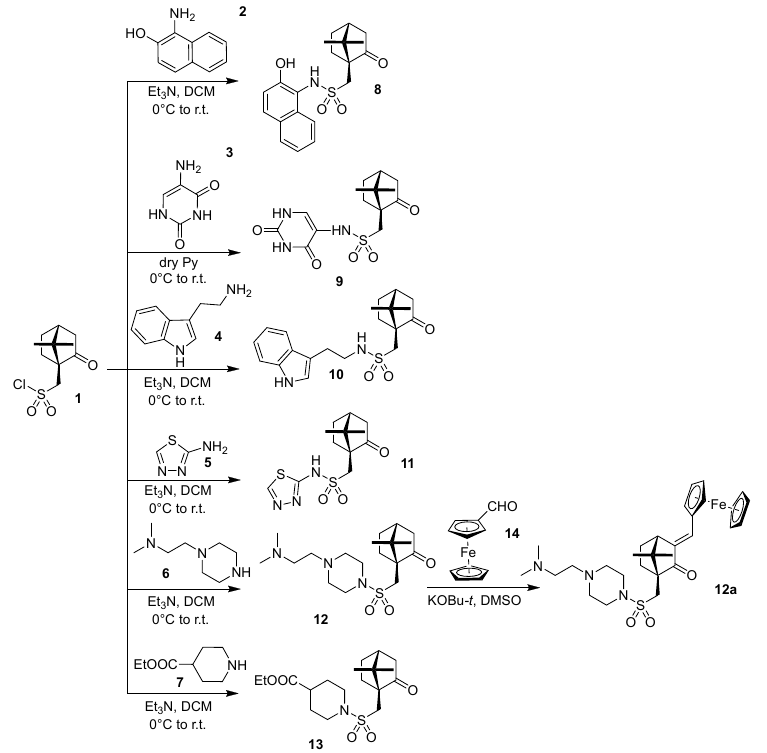
Figure 1. Synthesis of a series of new camphor sulfonamides. Compound 12a (1 S ,4 S ) ‐ 3 ‐ (( E ) ‐ ferroce ‐ nylmethylidene) ‐ 1 ‐ (4 ‐ (4 ‐ (2 ‐ (2 ‐ (dimethylamino)ethyl)piperazin ‐ 1 ‐ yl)sulfonyl)methyl) ‐ 7,7 ‐ dime ‐ thylbicyclo[2.2.1]heptan ‐ 2 ‐ one (working title CC ‐ 78) was chosen for further investigations.